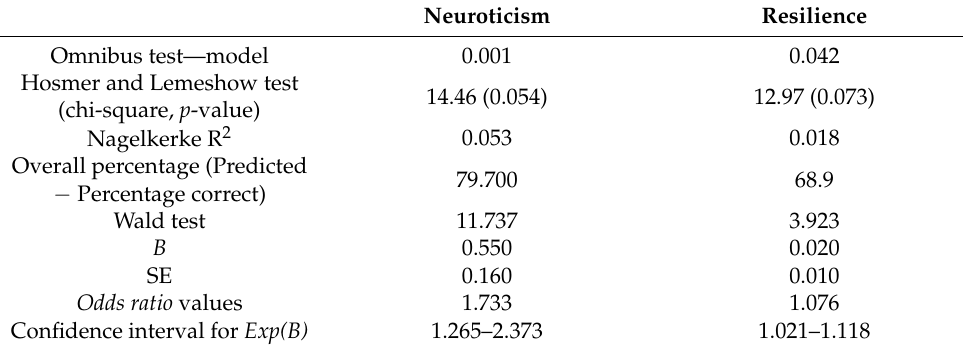
Table 3. Results of the binomial logistic regressions